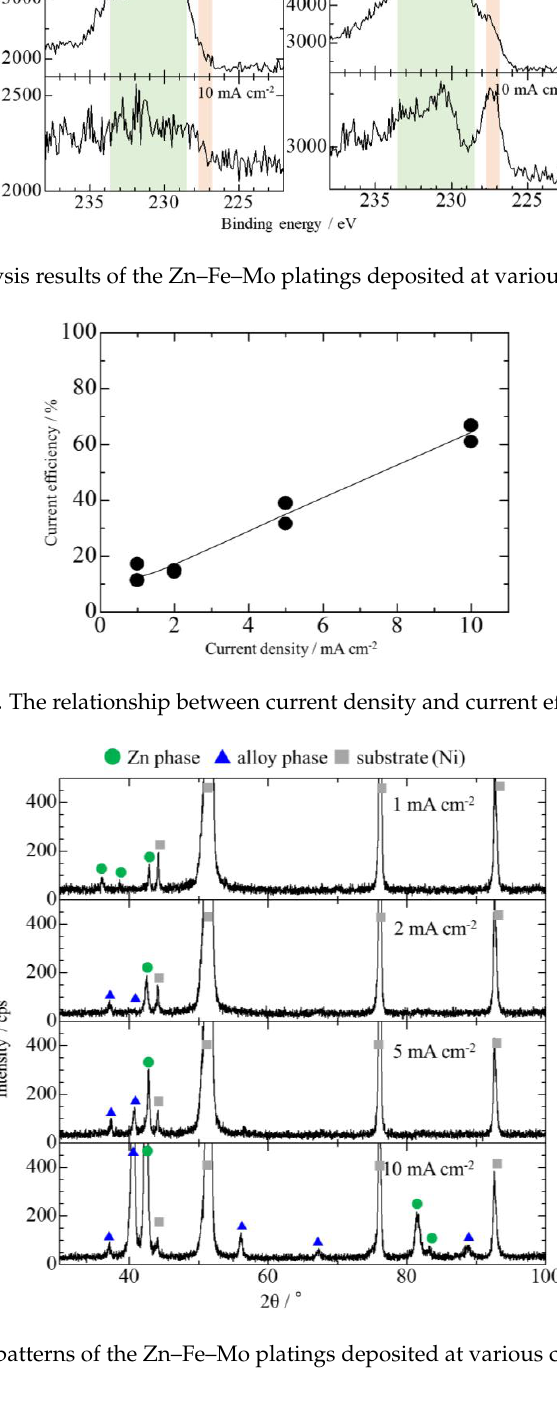
Coatings 2017 , 7 , 235 8 of 13